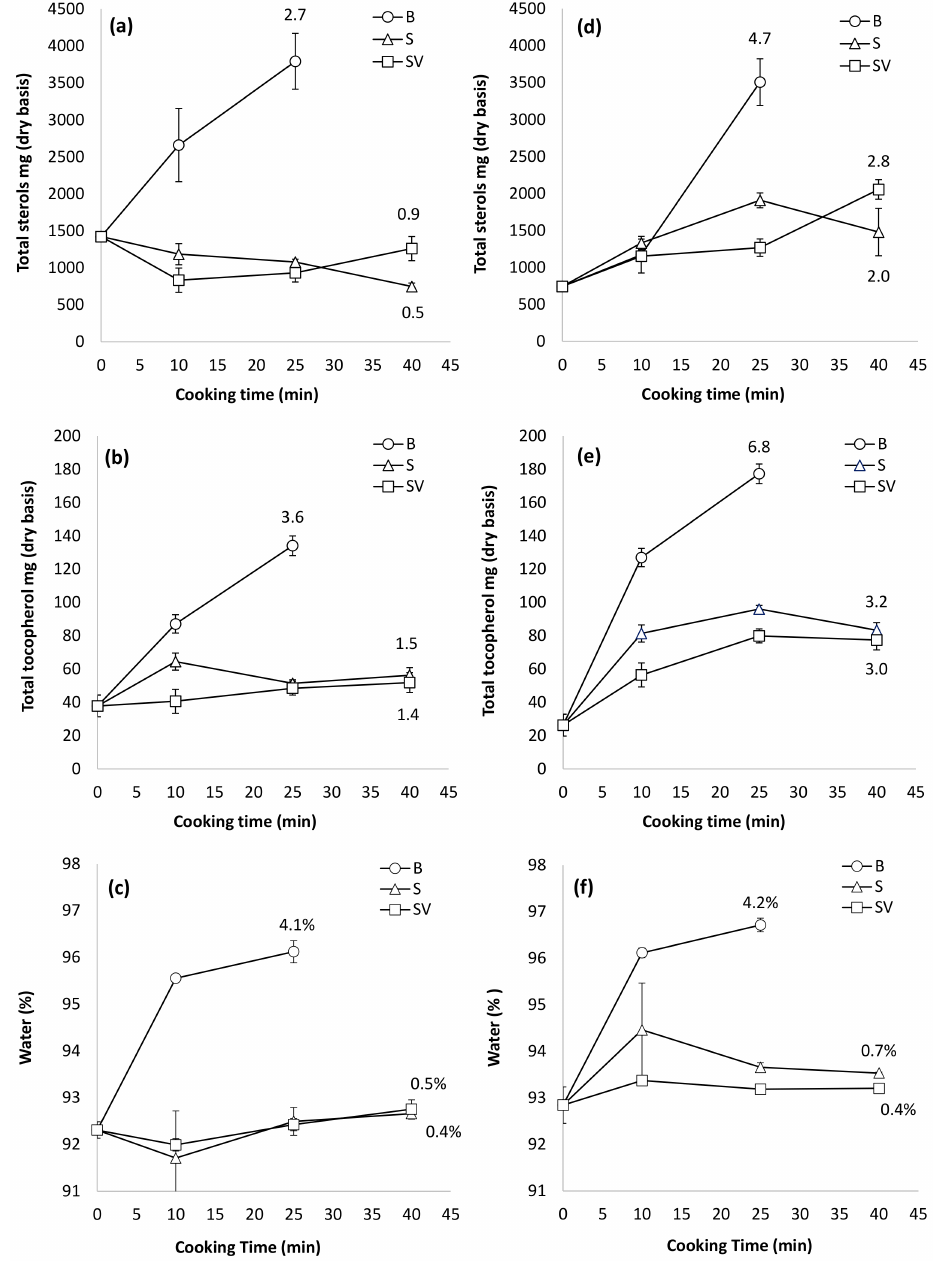
Figure 7. Total sterols ( a , d ) and total tocopherol ( b , e ) (expressed on dry basis) and percent of water ( c , f ) extracted from the Depurple (left) and Cheddar (right) cauliflower after 10, 25, and 40 min of heating under boiling (B), steaming (S), and sous-vide (SV). Error bars represent 95% confidence intervals. Numbers indicated as labels at the end of heating represent the ratio between the concentration of sterols, tocopherols, and water extracted from heated samples with respect to the fresh